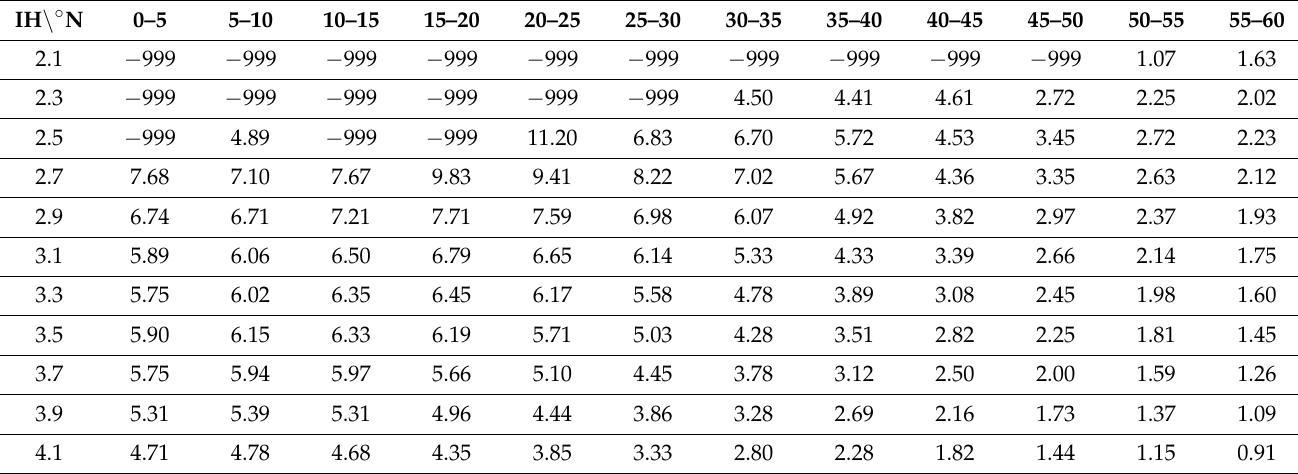
Table A2 give the values of RO bending angle error variances in every 5 ◦ -latitudinal band and 0.2-km impact height interval between 0 ◦ and 60 ◦ N. Similar to the refractivity error variance, the bending angle error variances in the Southern Hemisphere can be directly determined by referring to those in the corresponding latitudinal band in the Northern Hemisphere. Table A2. Mean error variances (unit: 10 − 6 rad 2 ) of RO bending angle in each 5 ◦ -latitude interval at each 0.2-km impact height (IH) level from 2.1 to 10.9 km between the equator and 60 ◦ N. Missing values are denoted as −